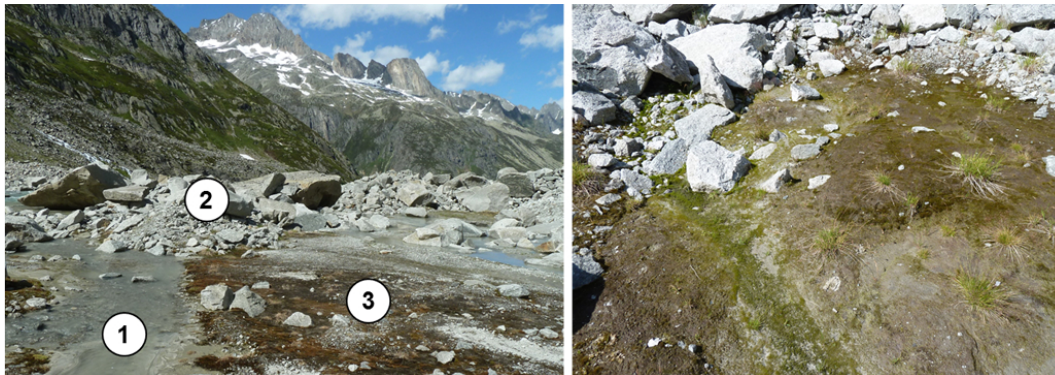
Fig. 3. BSCs at initial sites of the forefield of the Damma Glacier. The left picture shows that BSCs do not develop when water has destructive properties (1) or when the water holding capacity of the substrate is too low (2). However, under optimal hydrological conditions and in areas protected against erosion, BSCs develop (3). The right picture illustrates the frequently observed proximity of BSC and plants. Photos: J.